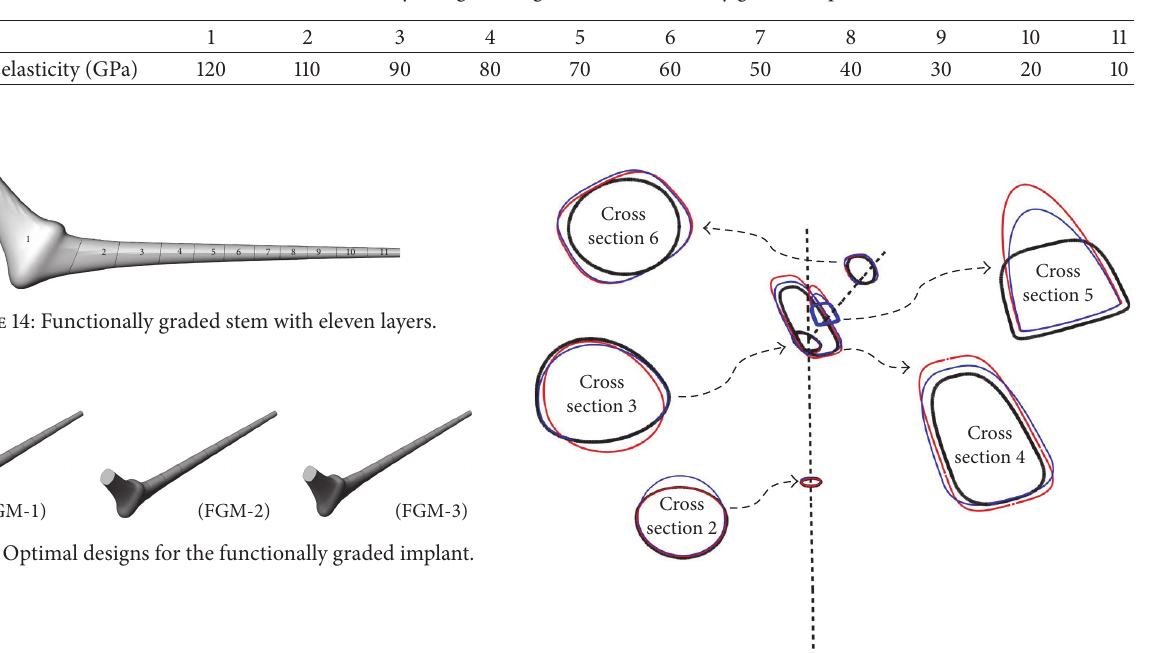
cross sections over the stem length (cross sections 1 to 3) and trapezoidal cross sections around the intersection of the neck and prosthesis axes; additionally the sizes of the cross sections increased from the proximal end of the implant to the end of the neck axis and decreased afterward toward the distal end of the implant as illustrated in Figure